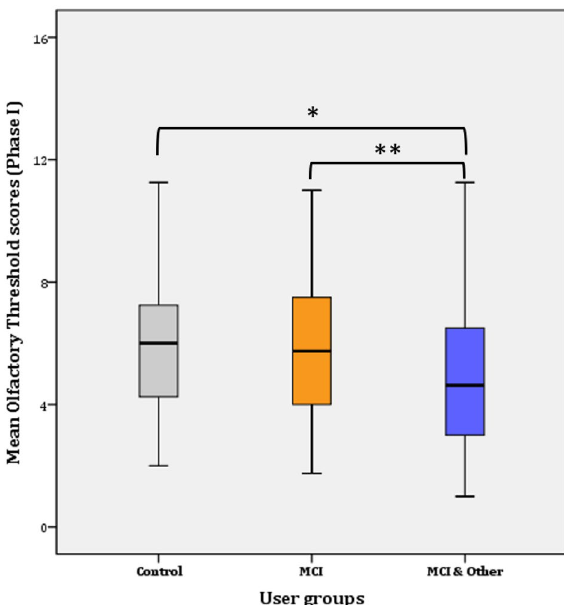
Figure 1. Mean Threshold scores per user group (Phase